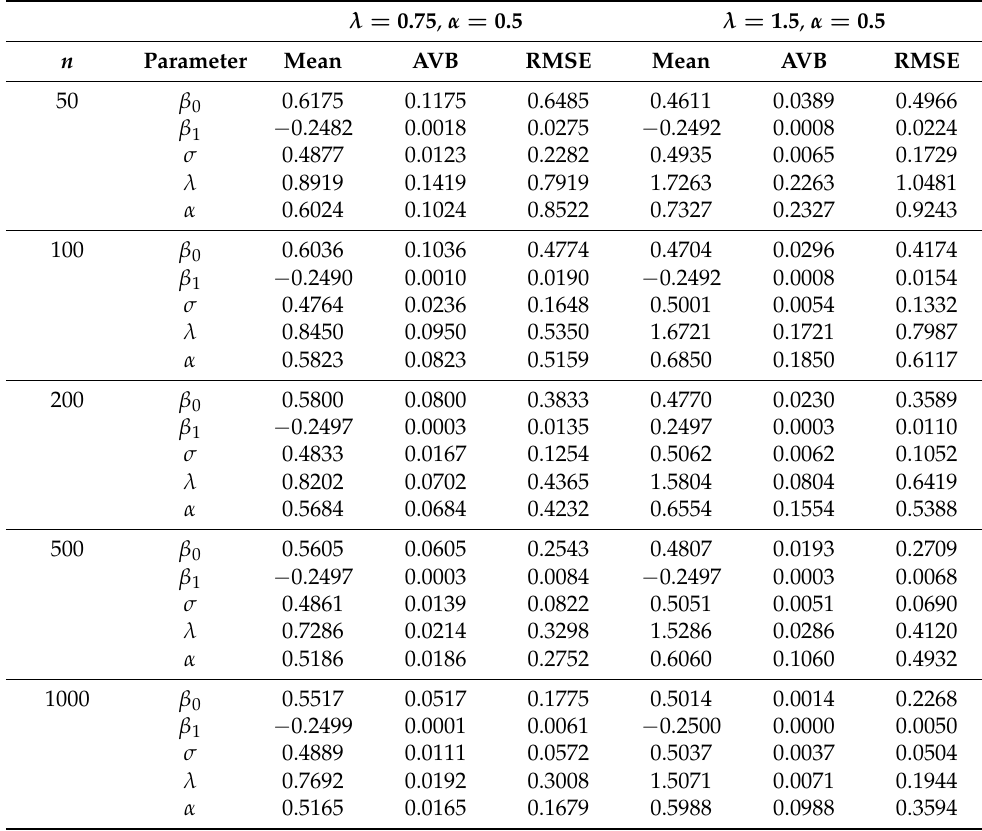
Table 3. MLE behaviors for the UPSN regression